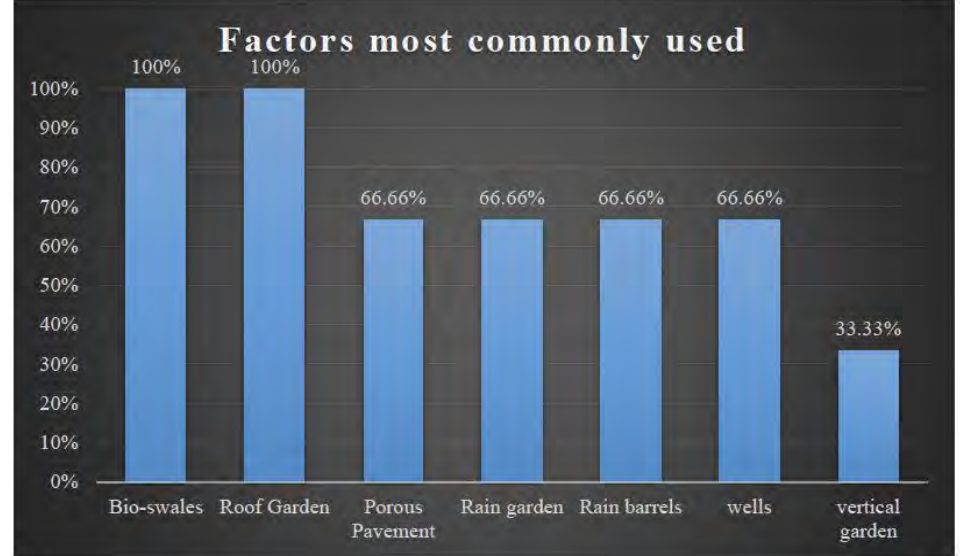
Fig.35: Factors of landscape commonly used in sustainable landscape projects. (The